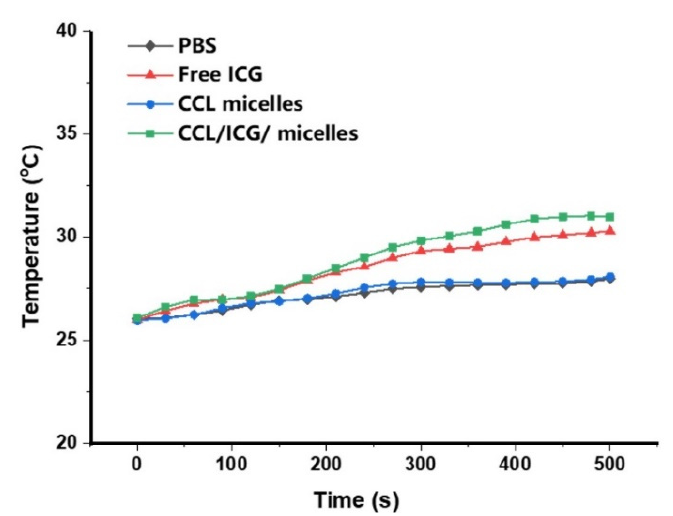
Figure 8. Profiles of temperature alteration of PBS, free ICG, CCL micelles, and CCL / ICG micelles as exposed by NIR light.